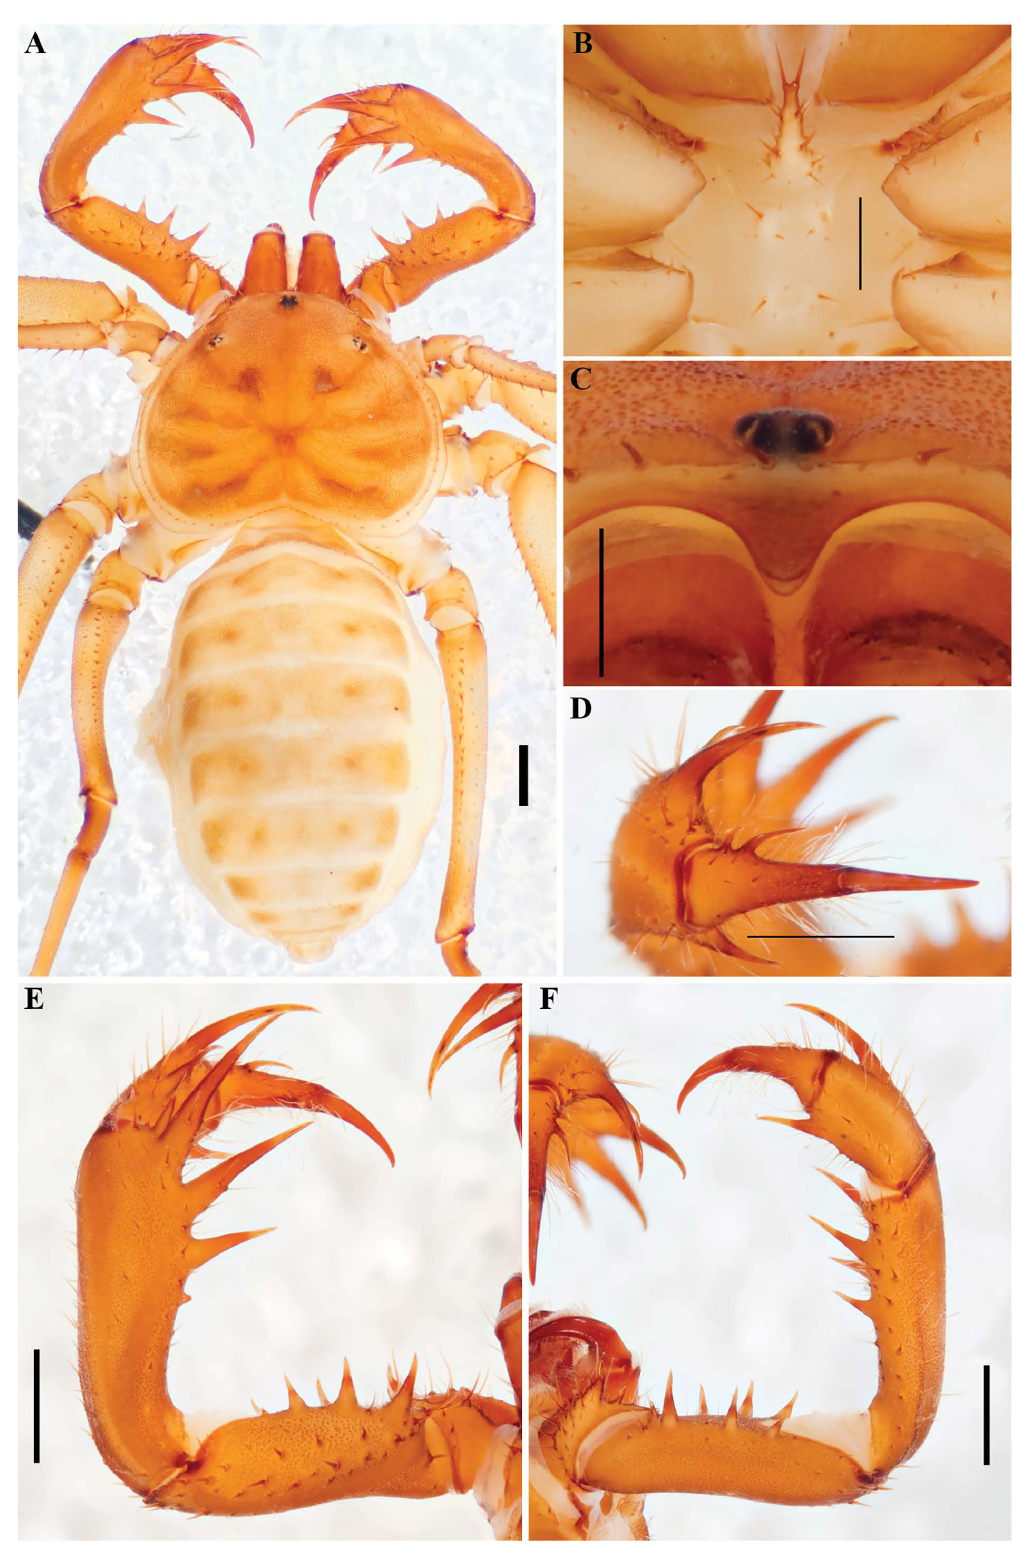
Fig. 95. Charinus cavernicolus Weygoldt, 2006 (MNHN), general morphology, ♀. A . Habitus, dorsal view. B . Sternum, ventral view. C . Frontal process. D . Pedipalp tarsus, frontal view. E . Pedipalp, dorsal view. F . Pedipalp, ventral view. Scale bars: A, E–F =1 mm; B–D =